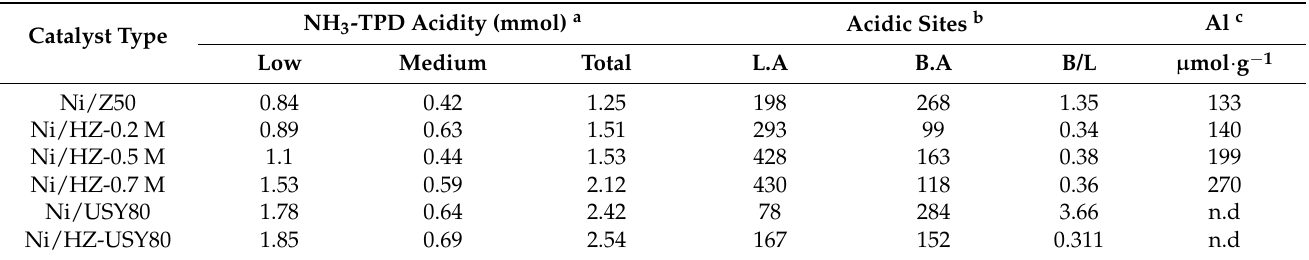
Table 3. Acidic and elemental composition characteristics of hierarchical zeolite